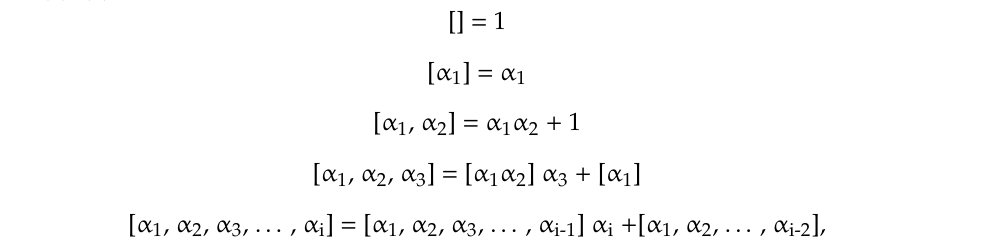
Figure 3. Optical layout with i-th and j-th group movement.